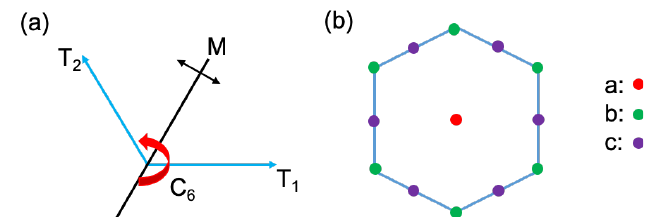
Figure 2: Panel (a) shows the generators of the wallpaper group p 6 m . In panel (b), the hexagon is a translation unit cell of the wallpaper group p 6 m . It has three IWP, usually labelled by a , b and c in crystallography, and they form the sites of the triangular, honeycomb and kagome lattices, respectively. The C the type- a